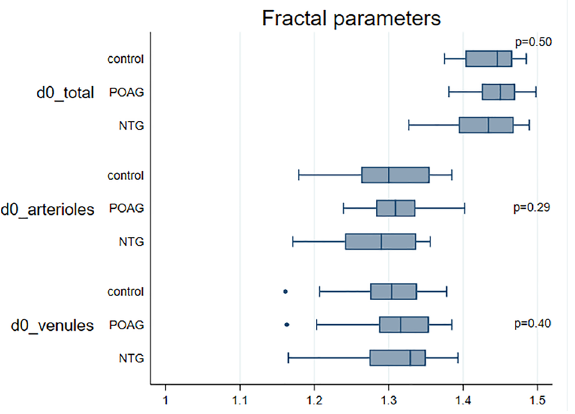
Figure 5. Bar graph of venular tortuosity values in the NTG, POAG and control groups. Data are expressed as median (interquartile range, 25–75th percentiles). d0 fractal dimension, NTG normal tension glaucoma, POAG primary open angle glaucoma.